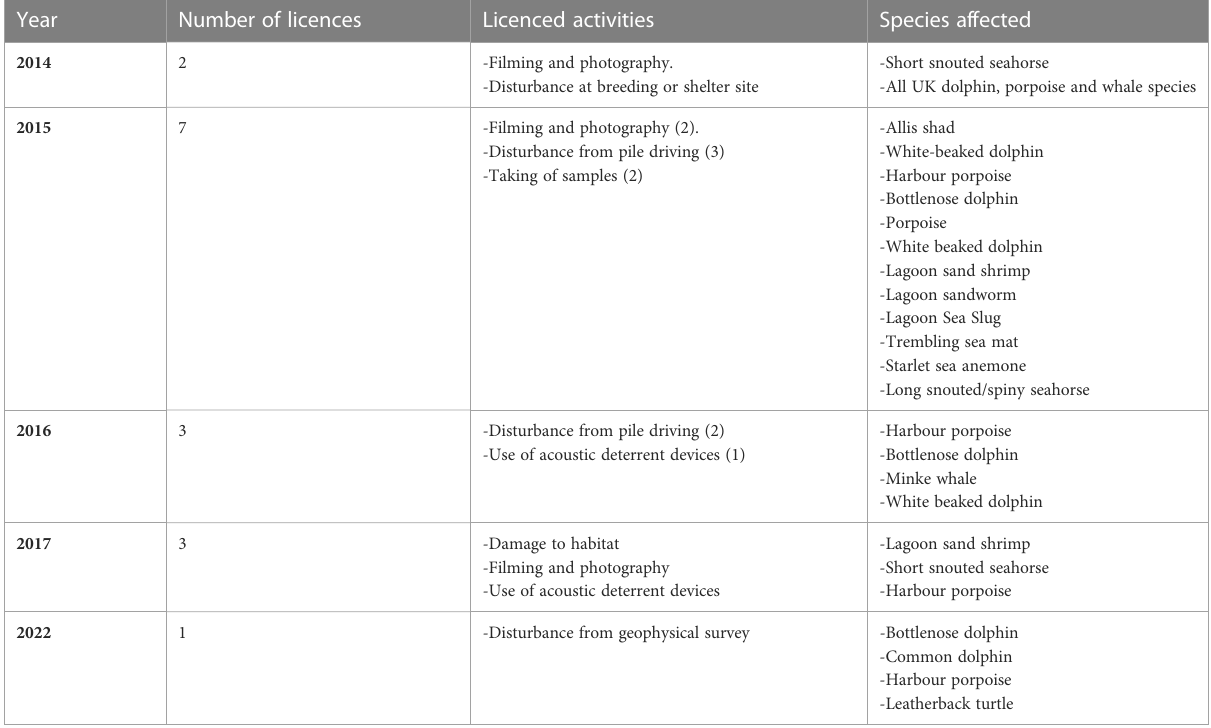
TABLE 1 Licences for Marine Wildlife Disturbance Activity